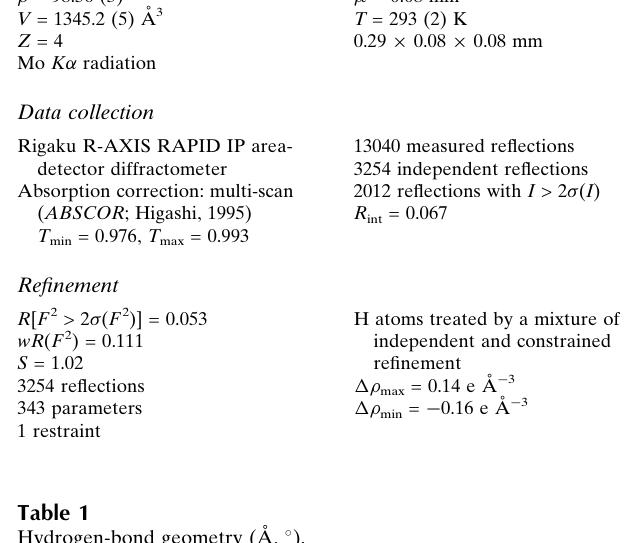
Hydrogen-bond geometry (A˚ , (cid:2) ). D —H (cid:1)(cid:1)(cid:1) A D